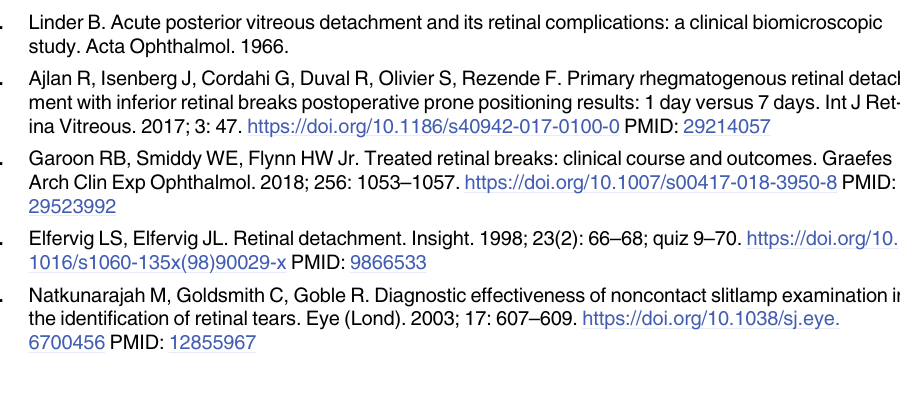
S1 Table. The number of retinal breaks detected by indirect ophthalmoscopy performed by qualified attending ophthalmologists and by UWF imaging